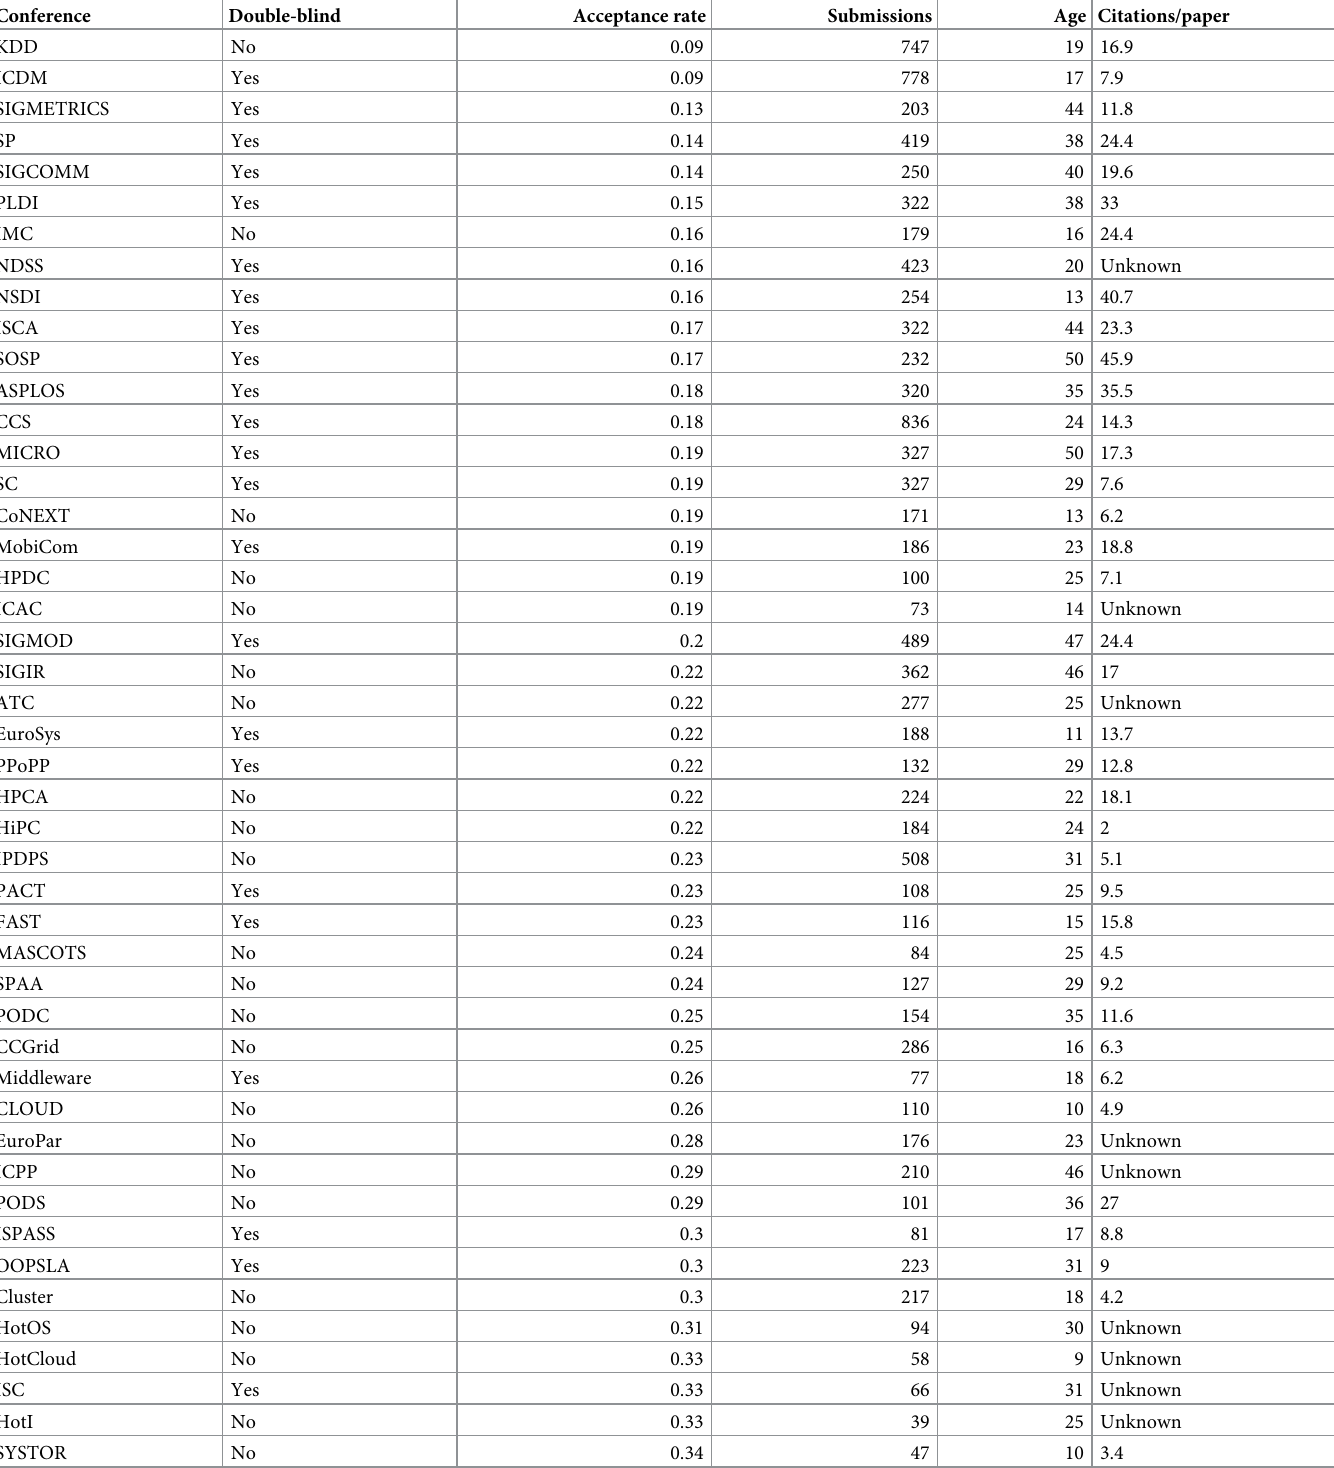
Table 1. System conferences and review policy with four reputation or prestige metrics: Acceptance rate, total number of paper submissions in 2017, age of confer- ence in years, and mean historical citations per paper, which are all correlated ( p < 0.01). Conferences are sorted by descending acceptance